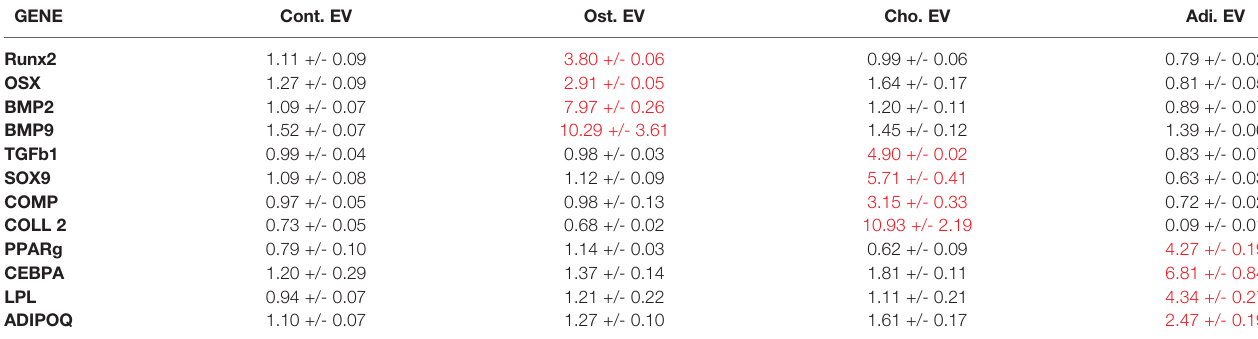
Table represents fold changes in gene expression levels of representative marker genes for osteogenic, chondrogenic and adipogenic differentiation of HMSCs after treatment of naïve HMSCs for 72 h with the EVs isolated from naïve and respectively differentiated HMSCs. The data are presented as mean fold change +/ − SD with respect to control (n= 4). Red lettering within the table denotes lineage speci fi c